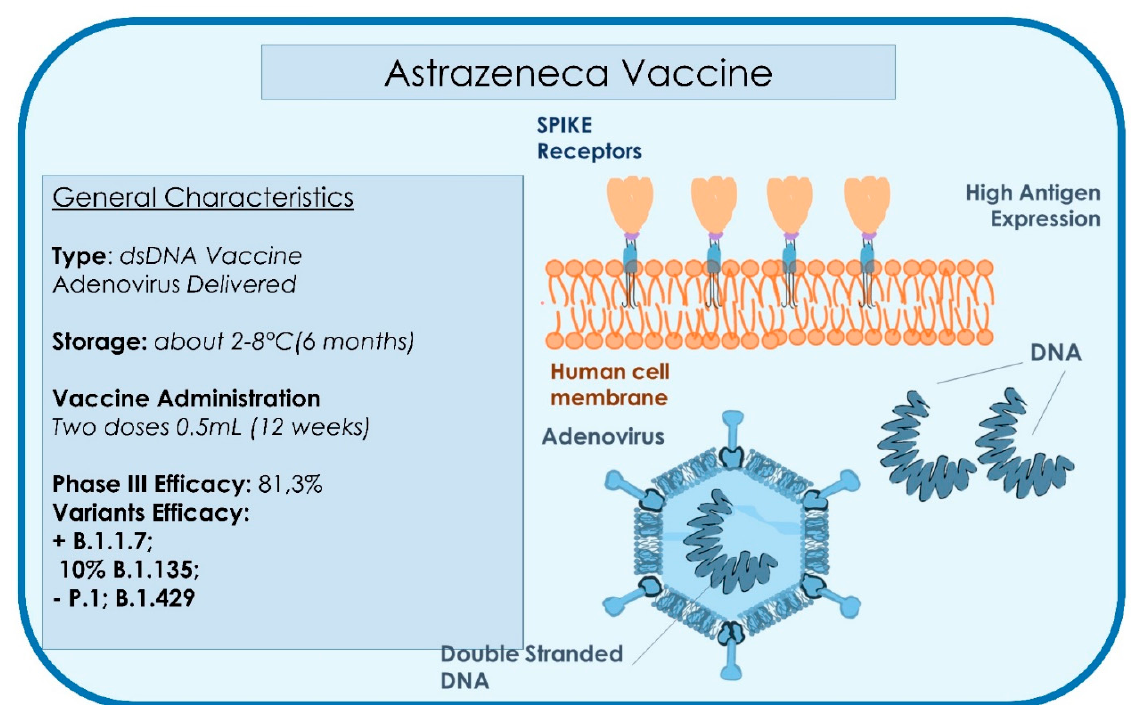
Figure 7. Summary of the type, storage administration, and efficacy characteristics of the AstraZeneca Vaccine.